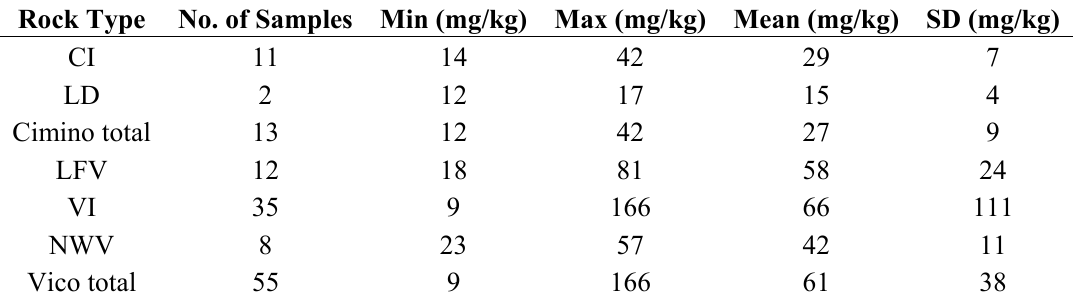
Table 3. Arsenic concentrations in rocks (SD = standard deviation).